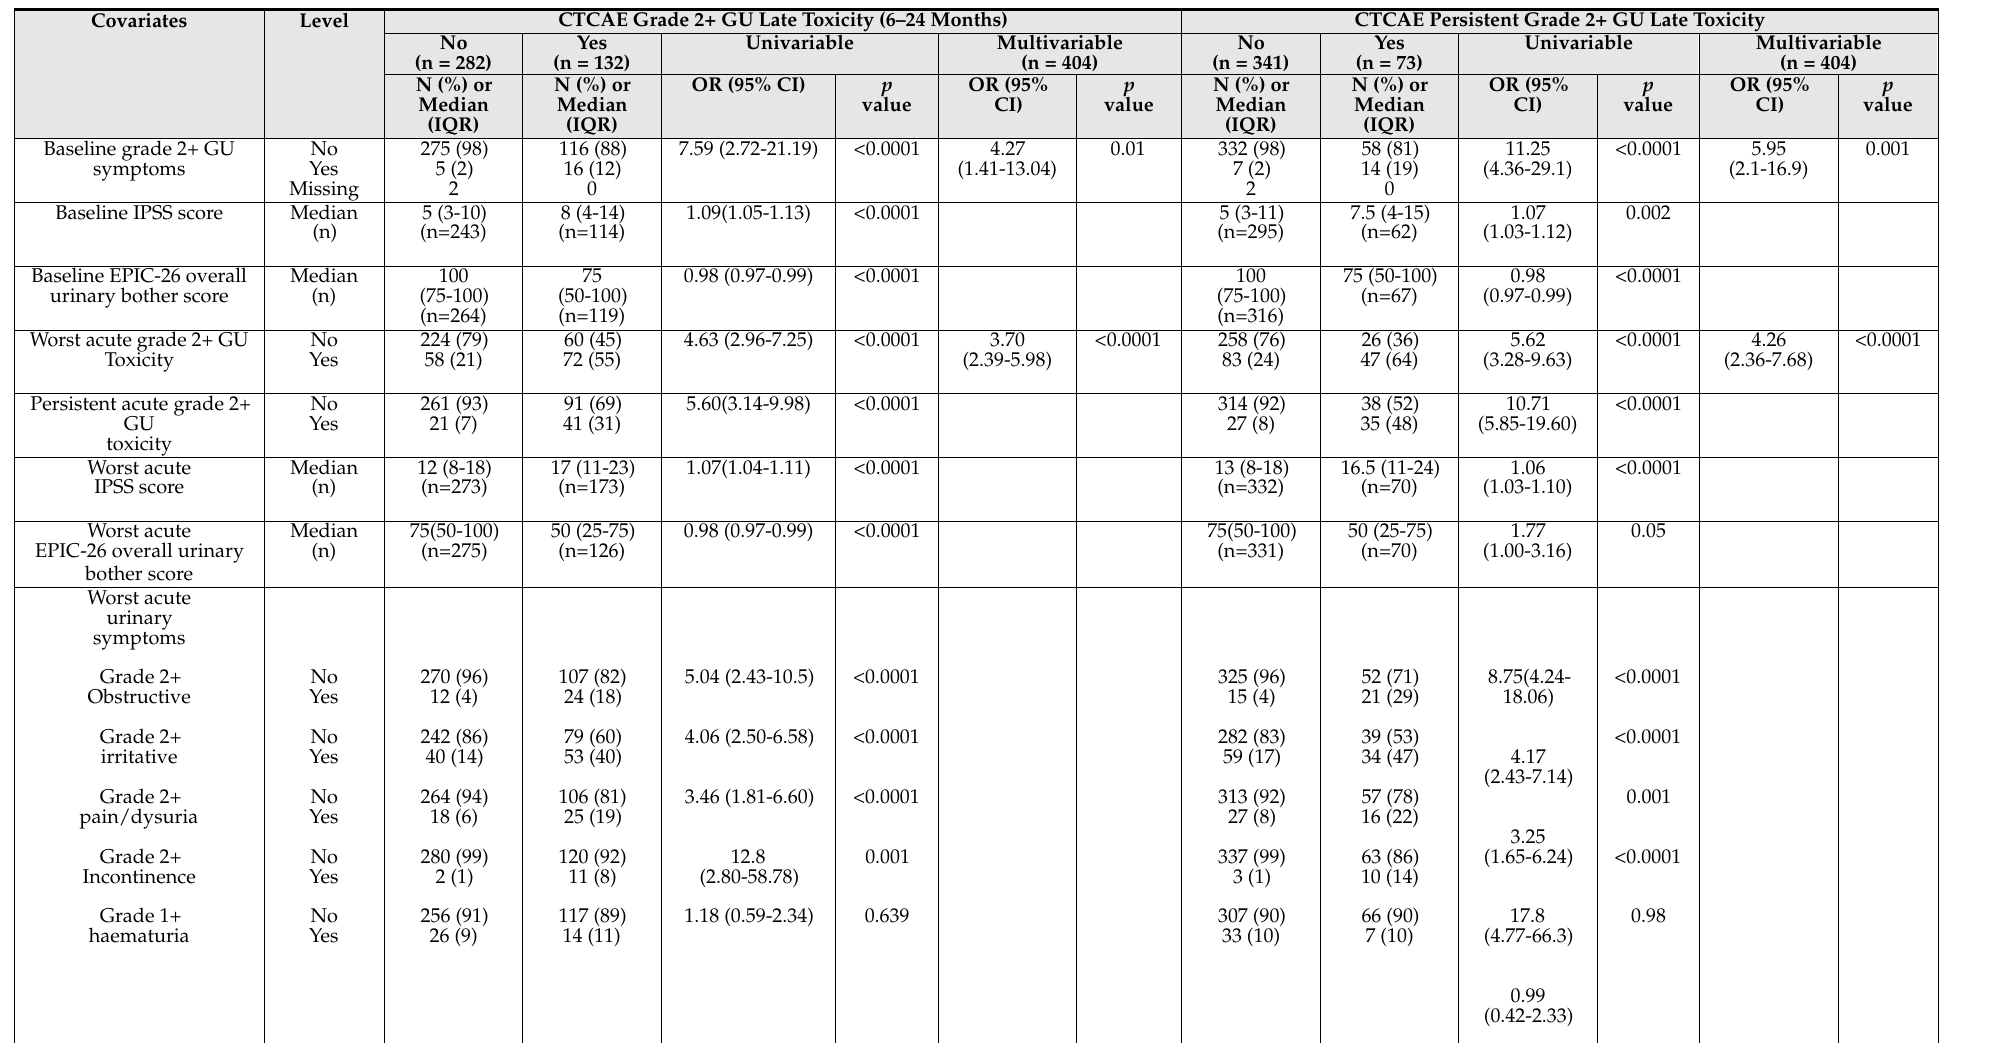
Table 2. Univariable and multivariable logistic regression model to identify covariates associated with CTCAE late genitourinary toxicity after